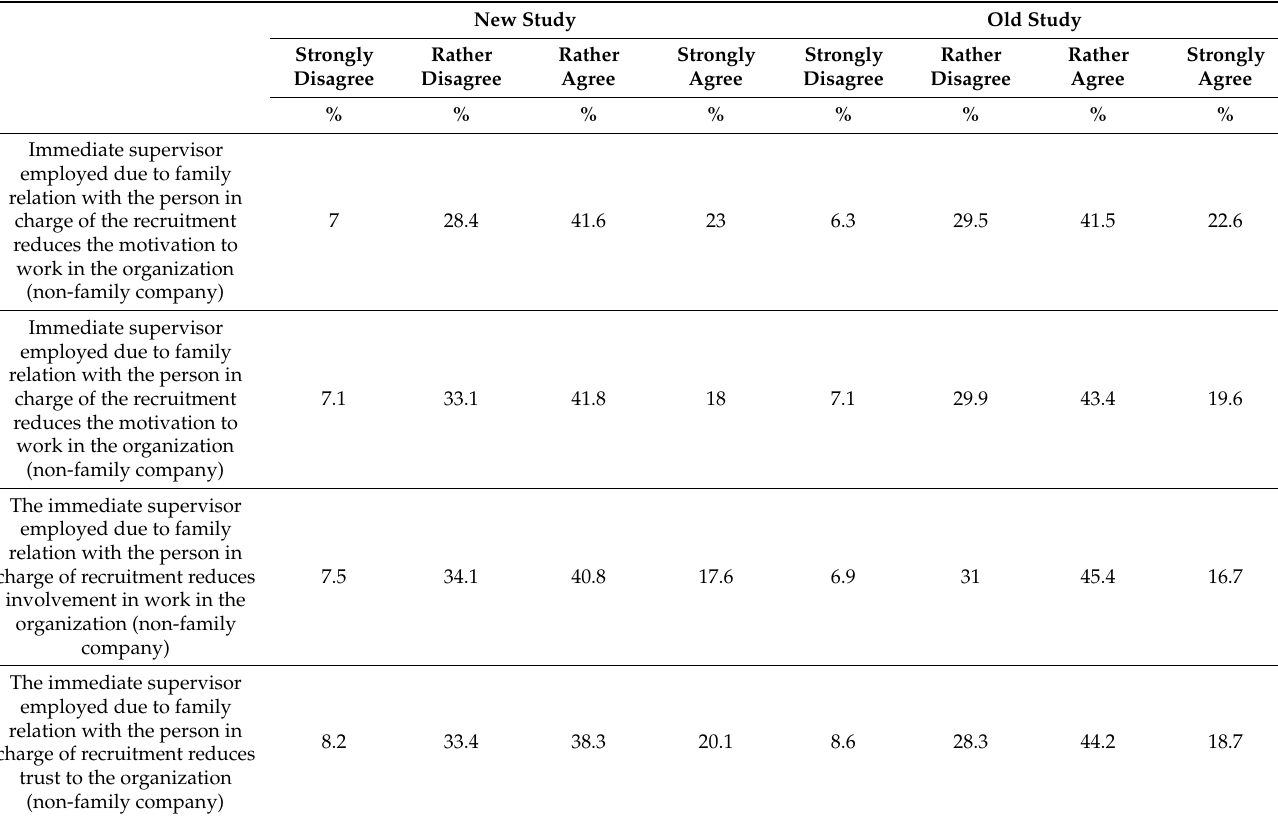
Table 17. Impact of nepotism on employees in a non-family